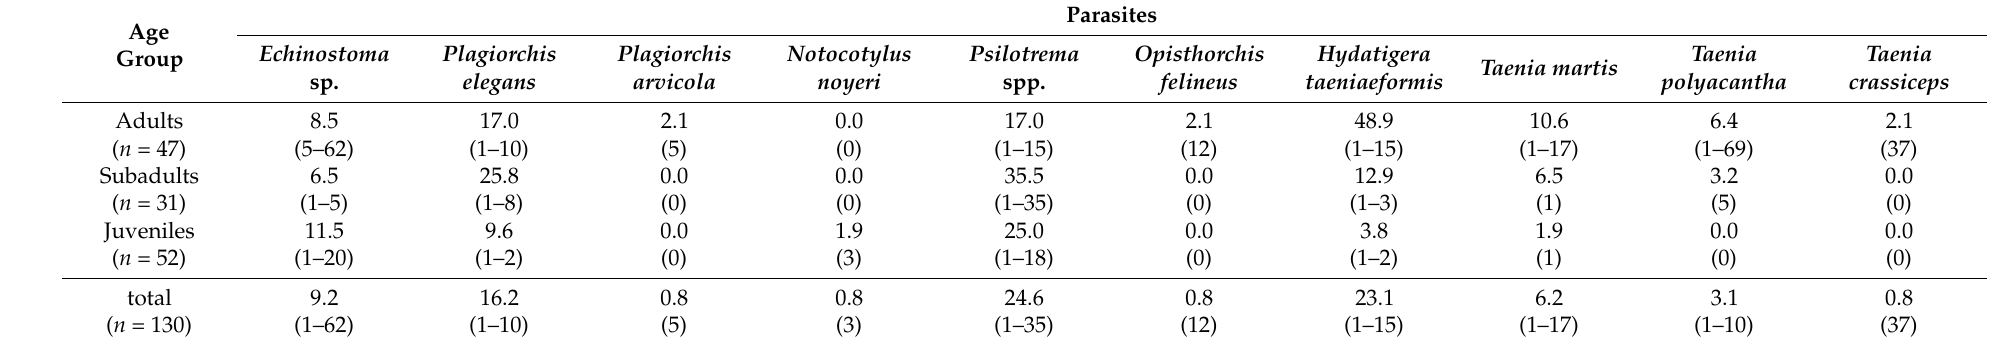
Table 3. Prevalence of eleven parasite species found in muskrats in the Barnim district of Brandenburg state (range of intensity is given in brackets). The two species of Psilotrema are combined as Psilotrema spp.